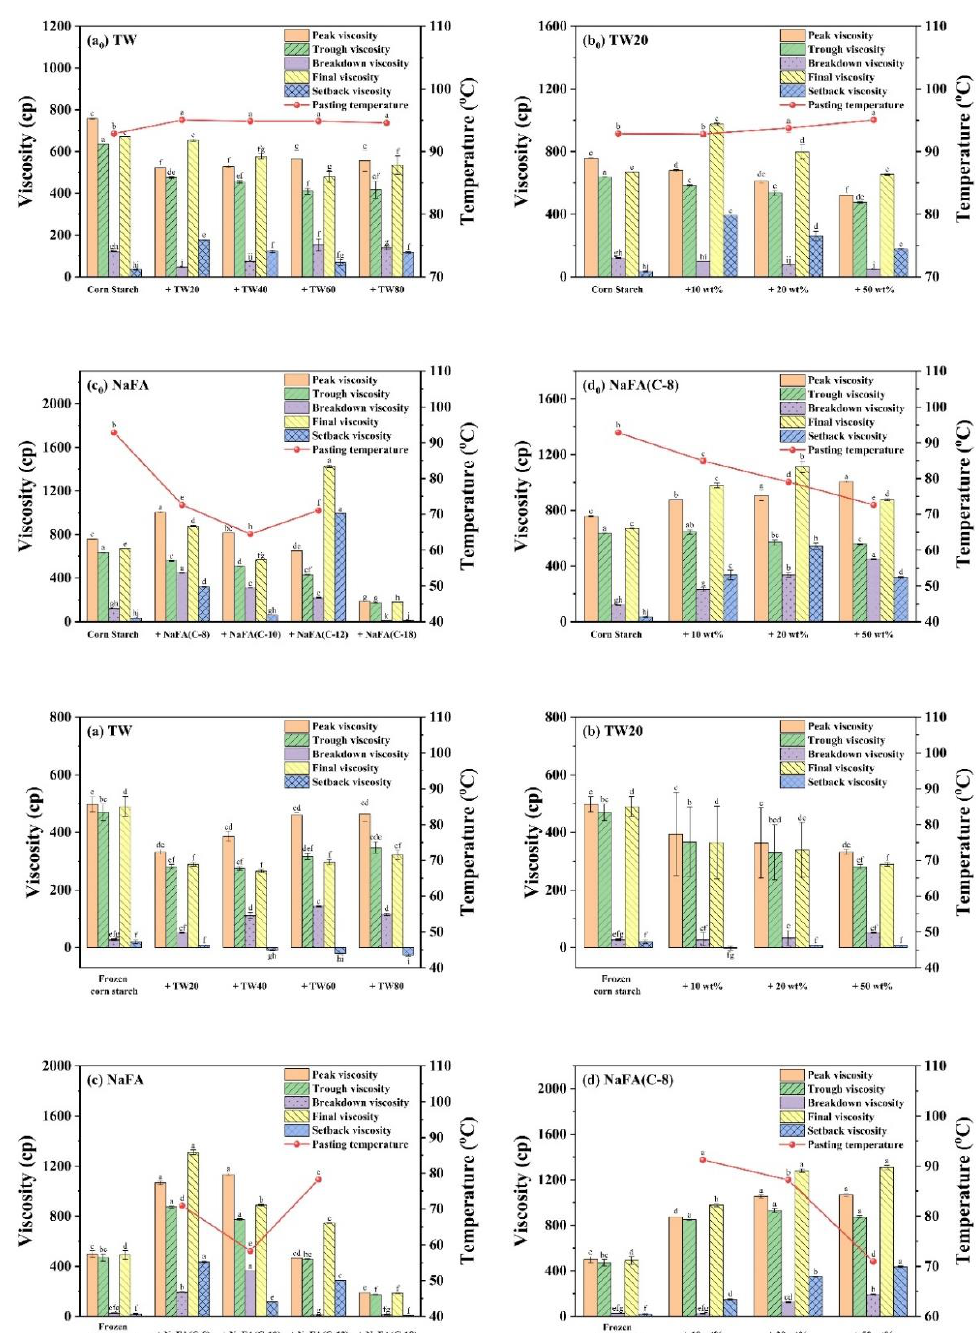
Figure 2. Pasting parameters (viscosity and pasting temperature derived from RVA curves) of regular or frozen corn starch in the presence of Tween (TW) and sodium fatty acid (NaFA). ( a 0 , a ) Pasting parameters in the presence of different types of TW (50 wt%). ( b 0 , b ) Pasting parameters in the presence of different concentrations of TW20. ( c 0 , c ) Pasting parameters in the presence of different types of NaFA (50 wt%). ( d 0 , d ) Pasting parameters in the presence of different concentrations of NaFA (C-8). Means with different letters differed significantly at p < 0.05.